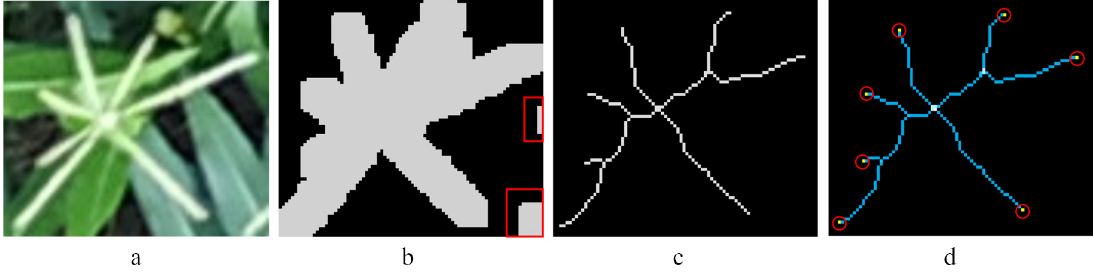
Figure 13. The calculation of tassel branch number. ( a ) Original image. ( b ) Binary image after morphological dilatation. ( c ) Tassel skeleton. ( d ) Endpoint